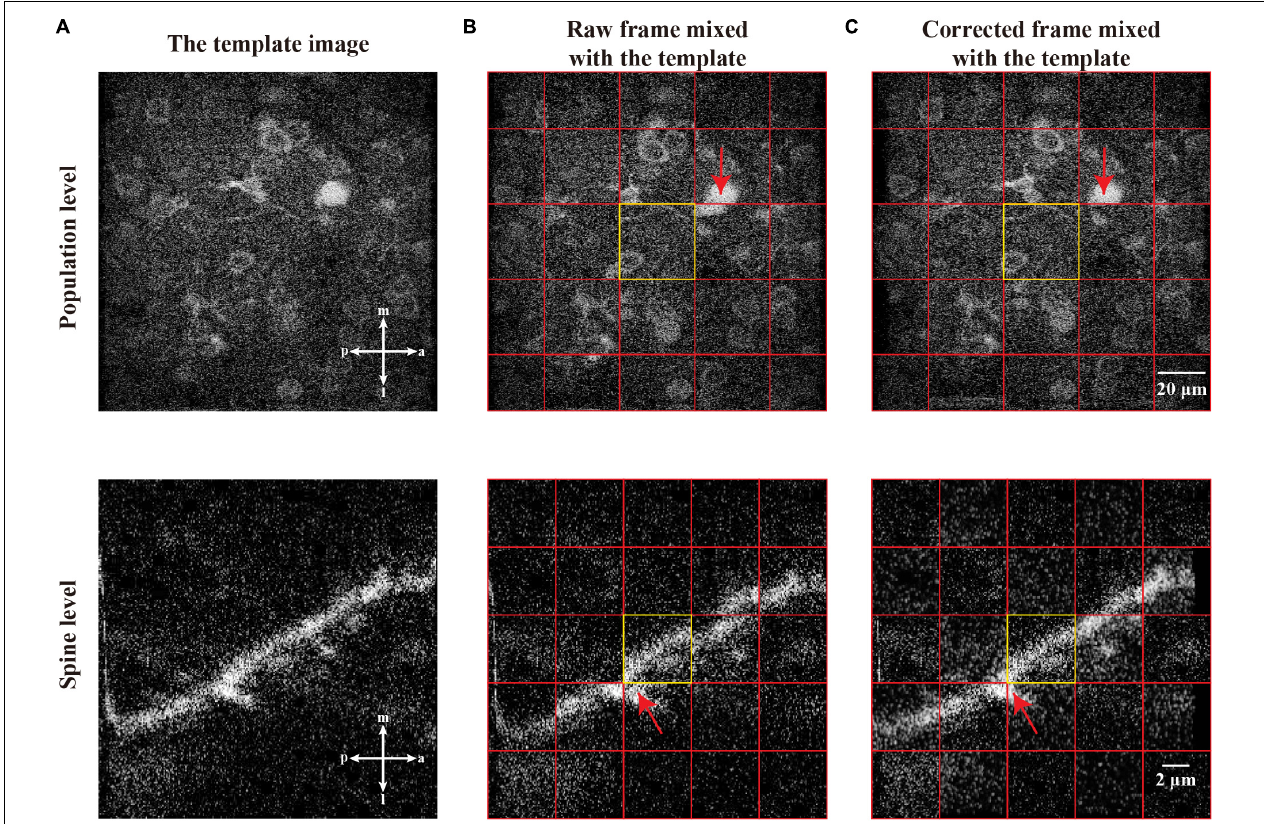
FIGURE 10 | The motion correction effect in single raw frame of two-photon imaging data. (A) The template images of the population level and spine level. (B) Raw frames from population level and spine level with motion artifacts which are mixed with corresponding template image. (C) The correction of the raw frames, which are mixed with corresponding template image. In a mixed image, the image patches from the template and single frame are equally distributed and marked by red grid lines. The equally distribution means any two adjacent patches are from the template image and single frame, respectively. Each center of the mixed image is a patch from corresponding template image, which is marked by yellow rectangle. The red arrows indicate the performance of